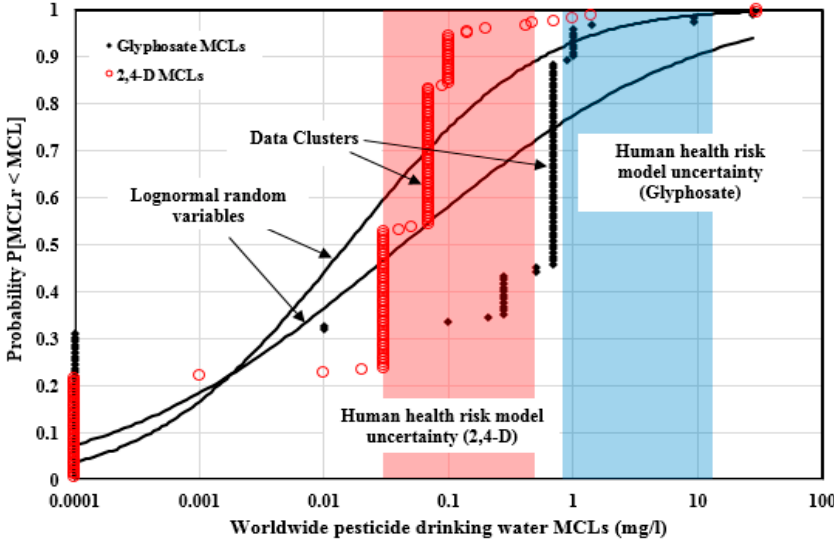
Figure 6. 2,4-D and Glyphosate drinking water MCLs plotted in the empirical cumulative distribution forms and compared to the log-normal random variable cumulative distributions with identical statistics.